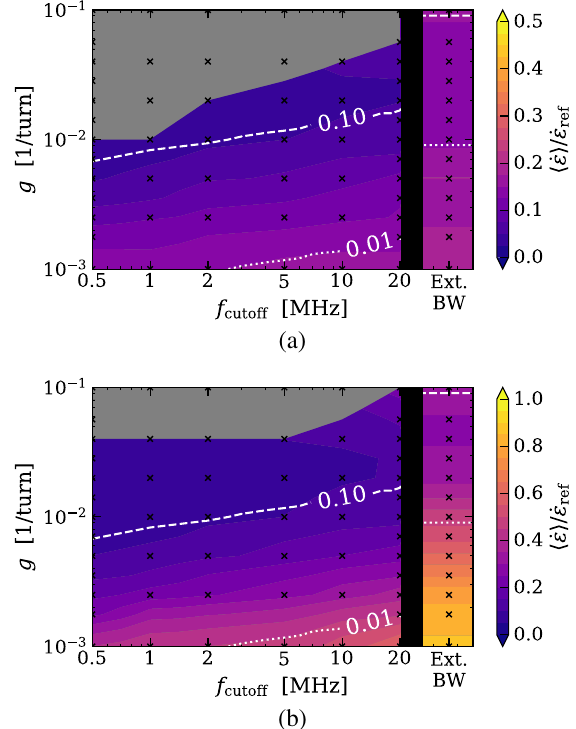
FIG. 8. Average emittance growth rate for 128 bunches sep- arated by 25 ns, after halving the BPM noise currently in the LHC, in a configuration with a beam-beam interaction and Q 0 ¼ 0 in (a) and Q 0 ¼ 15 in (b). The black crosses mark the simulations. The area marked gray contains configurations ð f cutoff ; g Þ for which the feedback loop is unstable. The configu- rations at the edge of the gray area were stable. The white curves ˜ N are contours of constant maximum multibunch gain g